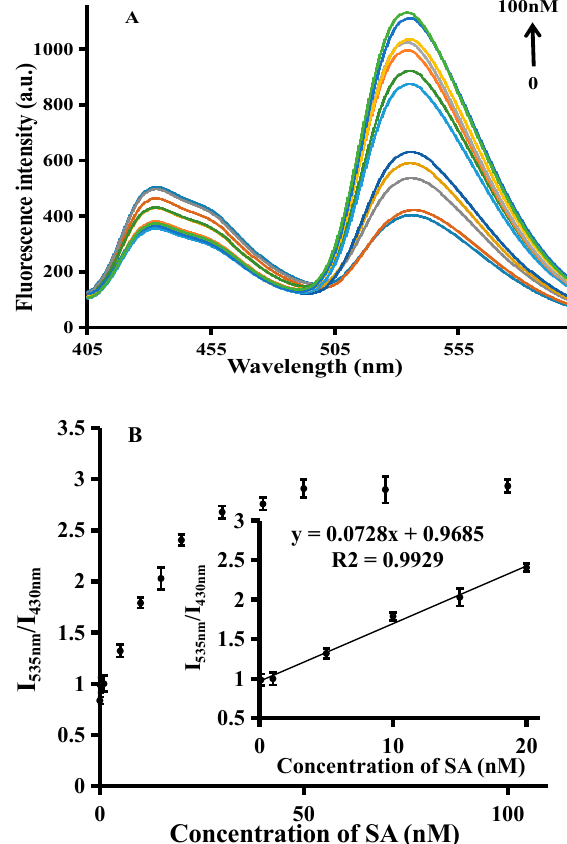
Figure 3. ( A ) Fluorescence emission spectra in the presence of increasing amounts of SA (0, 0.1, 1, 5, 10, 15, 20, 30, 40, 50, 70, 100 nM). ( B ) Graph depicting the changes in fluorescence output at 430 nm (PFP) and 535 nm (SG I) as a function of SA concentration. Inset: Linear relationship between fluorescence intensity and low SA concentrations. Error bars were estimated from three replicate measurements. Table 1. Comparison of different methods for the detection of SA.